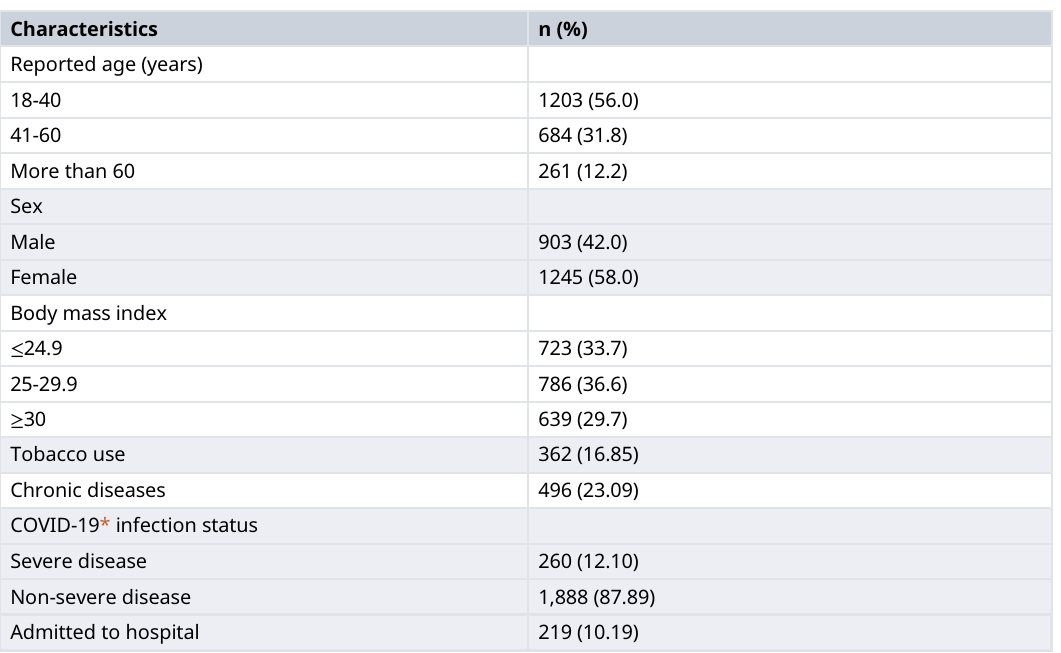
Table 1. Demographics of the